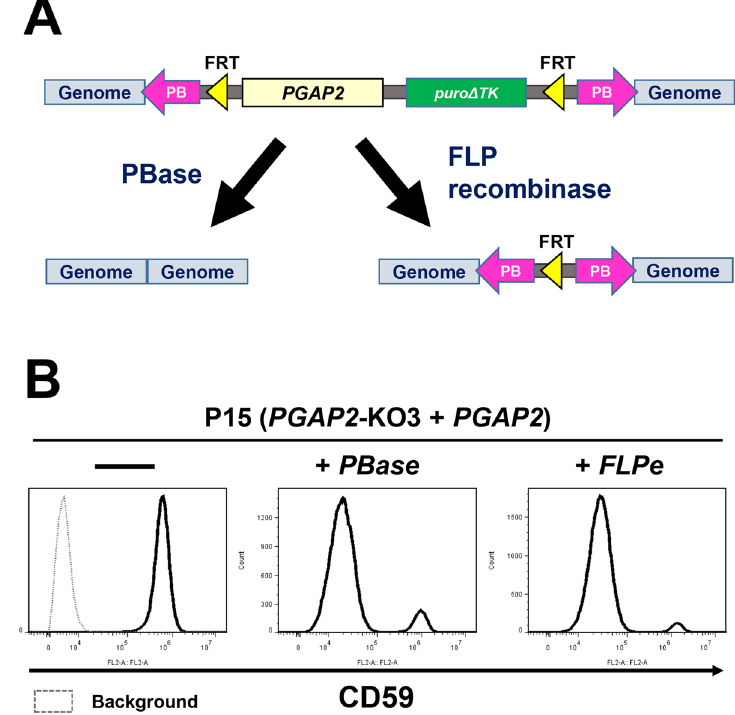
Figure 4. Re-excision of the PB transposon. ( A ) The PB element in the genome was re-excised by the expression of PBase or FLP recombinase. ( B ) Flow cytometric analysis of P15 cells after expression of PBase and FLP recombinase, followed by FIAU treatment. CD59 on the cell surface was